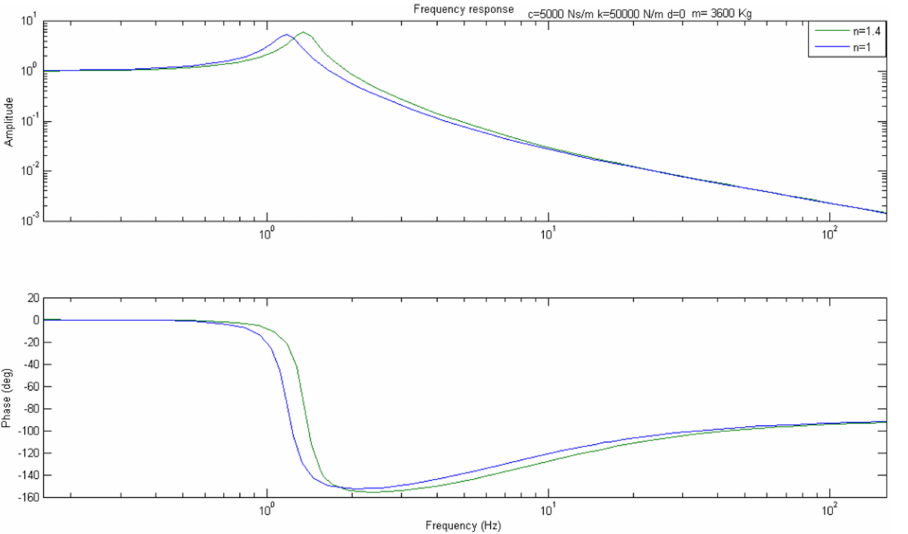
Figure 6 – Transfer function of vertical displacement for the adiabatic/ isothermal exchange Slika 7 – Prenosna funkcija vertikalnog pomeranja za adijabatsku/izotermnu razmenu Рис . 7 – Передаточная функция вертикального сдвига при адиабатическом